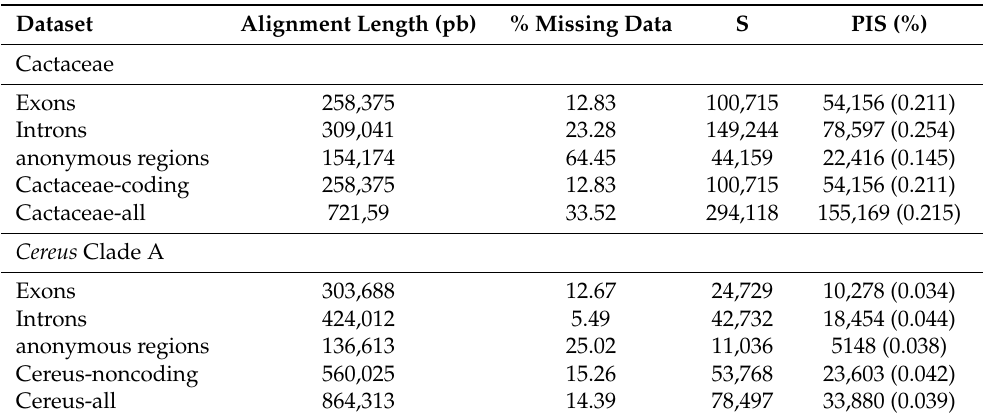
Table 1. Summary statistics of nucleotide variation calculated for coding, noncoding, and anonymous regions in the Cactaceae and Cereus datasets. Note: bp, base pairs; S, variable sites; PIS (%), parsimony informative sites (proportion of